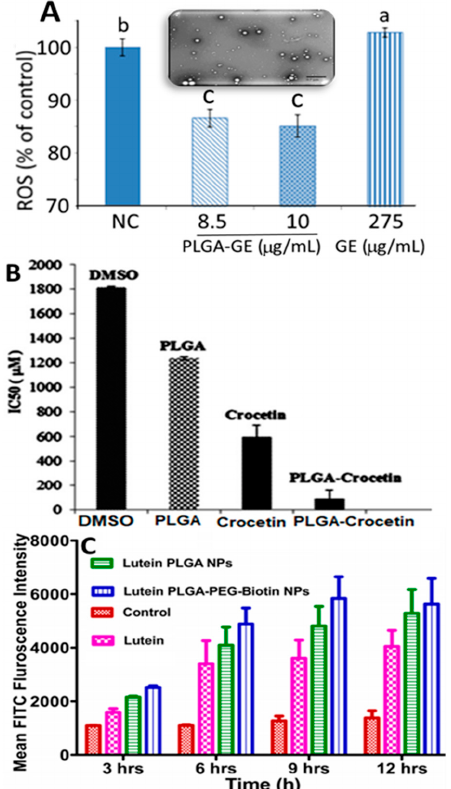
Figure 8. Poly(lactic-co-glycolic acid)-based polymeric nanoparticles for nanoencapsulation of carotenoid-rich Guabiroba fruit extract ( A ), crocetin ( B ) and lutein ( C ). Panel A illustrating generation of reactive oxygen species in HT-29 colon cancer cells treated with poly(lactic-co-glycolic acid)-based Guabiroba fruit extract nanoparticles along with an inset showing their transmission electron microscopic image, while panel B depicting half-maximal inhibitory concentration value for cytotoxicity effects of dimethyl sulfoxide, free crocetin and poly(lactic-co-glycolic acid)-crocetin nanoparticles on human breast cancer cells MCF-7 ( B ) as well as panel C showing fluorescence activated cell sorting analysis of control, free lutein, lutein-poly(lactic-co-glycolic acid) nanoparticles and lutein-loaded poly(lactic-co-glycolic acid)-polyethylene glycol-biotin nanoparticles after treatment with human retinal pigment epithelial cells ARPE-19 at different time periods (3–12 h). The results were expressed as mean ± standard deviation of ≥ 3 independent replicates and error bars represent the standard deviation from mean values, while different lowercase letters above each bar in ( A ) represent significantly different values. DMSO = dimethyl sulfoxide, PLGA = poly (lactic-co-glycolic acid), PEG-polyethylene glycol, FACS = fluorescence activated cell sorting, FITC = fluorescein isothiocyanate, GE = Guabiroba fruit extract, ROS = reactive oxygen species and IC 50 = half maximal inhibitory concentration. Adapted with permission from Pereira, et al. [40], Hafezi Ghahestani, et al. [49], and Bolla, et al. [47].